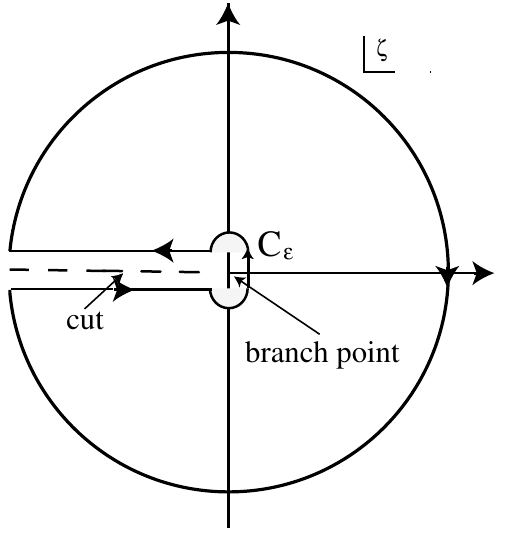
FIG. 9. The path of integration in Eq. (D8) in order to prove Eqs.